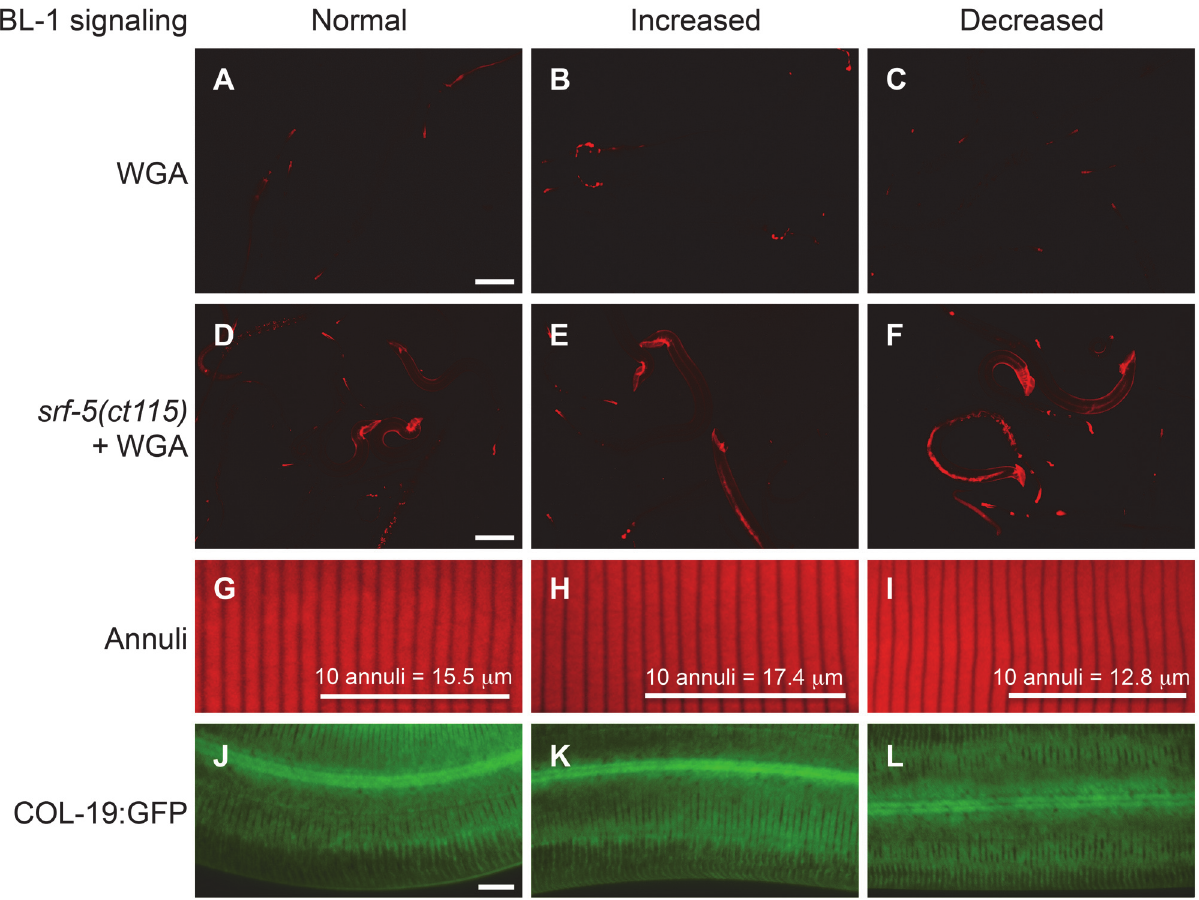
Figure 4. DBL-1 signaling affects specific cuticular surface properties. (A – C) Rhodamine-conjugated wheat germ agglutinin (WGA) staining in wild-type (A), dbl-1(++) (B), and dbl-1(nk3) (C) populations. Scale bar = 100 µ m. (D – F) WGA staining in him-5(e1490); srf-5(ct115) animals with C06C3.5(RNAi) (pseudogene control RNAi) (D), lon-2(RNAi) (E), and dbl-1(RNAi) (F). Scale bar = 100 µ m. (G – H) Staining of annuli in wild-type (G), dbl-1(++) (H), and dbl-1(nk3) (I) animals. Bars mark the length of 10 annuli and indicate the average length of 10 annuli for each strain. (J – L) COL-19:GFP expression in otherwise wild-type animals with C06C3.5(RNAi) (pseudogene control RNAi) (J), lon-2(RNAi) (K), and dbl-1(RNAi) (L). Scale bar = 10 µ